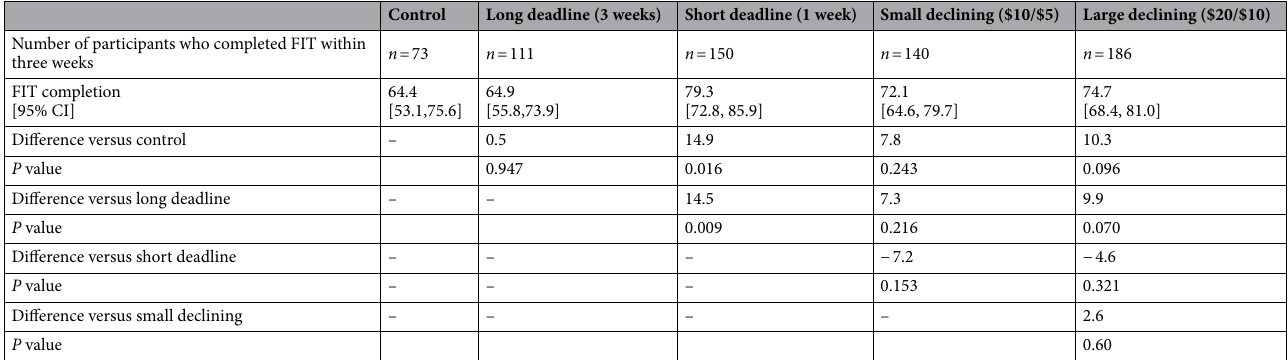
Table 3. FIT completion within 1 week, conditional on completion within 3 weeks. 1 The declining incentive conditions included incentivized deadlines: small declining incentive ($10 for completion within 1 week or $5 for completion within 3 weeks) and large declining incentive ($20 for completion within 1 week or $10 for completion within 3